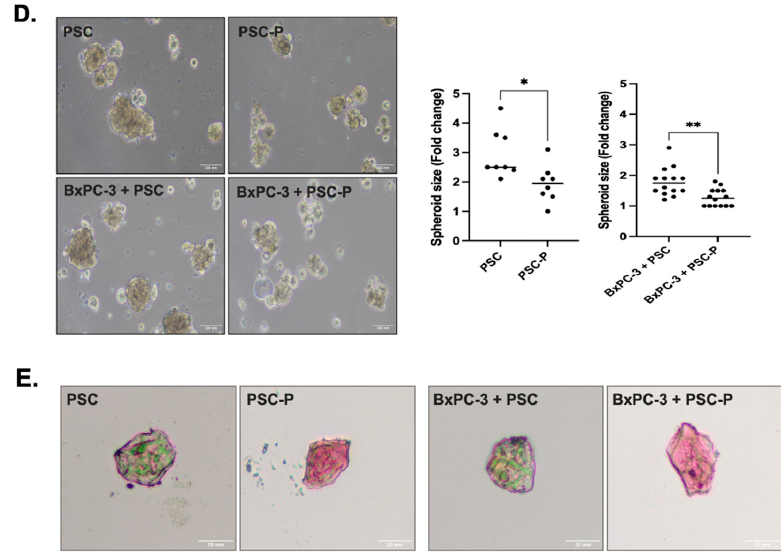
Figure 2. Periostin suppression in PSCs decreased their invasion, and reduced the size and extra- cellular collagen in spheroids. ( A ) The changes in periostin protein expression were evaluated by Western blot. The phase contrast images were added to show general cell morphology in both the control sgRNA and POSTN sgRNA group indicating there were no changes in cell morphology and viability after POSTN suppression. ( B ) α -SMA positivity of control and POSTN sgRNA groups were evaluated by immunofluorescent staining. Red; a-SMA staining, blue; DAPI staining. Arrows show decreased α -SMA positivity in POSTN sgRNA group. ( C ) The changes in the invasion ability of non-treated PSC cells and periostin-suppressed cells (named PSC-P) were assessed by matrigel drop analysis. Cells were seeded into matrigel drops and imaged on days 2 and 15. Graphs show the number of invasive cells. ( D ) The spheroid size was evaluated by measuring the spheroid di- ameter using Image J software (Fiji software, version 1.0). Upper images show the mono-culture spheroids of PSC and PSC-P cells. Lower images show co-culture spheroids generated by BxPC- 3+PSC cells and BxPC-3+PSC-P cells. ( E ) The changes in collagen levels of spheroids were evaluated by Trichrome Masson’s staining. Blue/green staining indicates collagen positivity in spheroids. * p < 0.05, ** p <